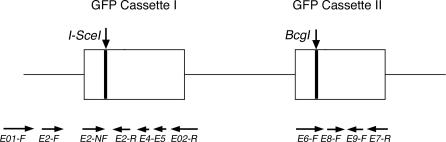
Location of the Primers Used for Methylation AnalysisSchematic of the DR-GFP transcriptional unit is shown. The arrows indicate the specific primers.